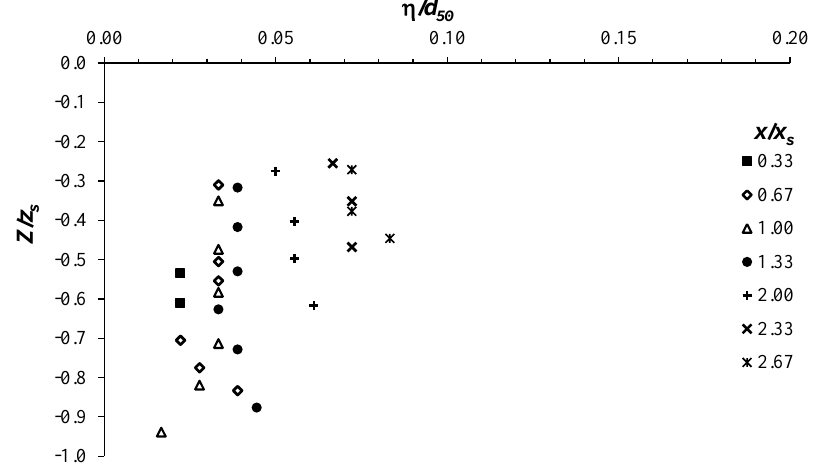
Figure 9. Vertical profiles of normalized Kolmogorov’s micro-scale, η / d 50 , at different downstream positions x / x s at the plane of flow symmetry ( y = 0).